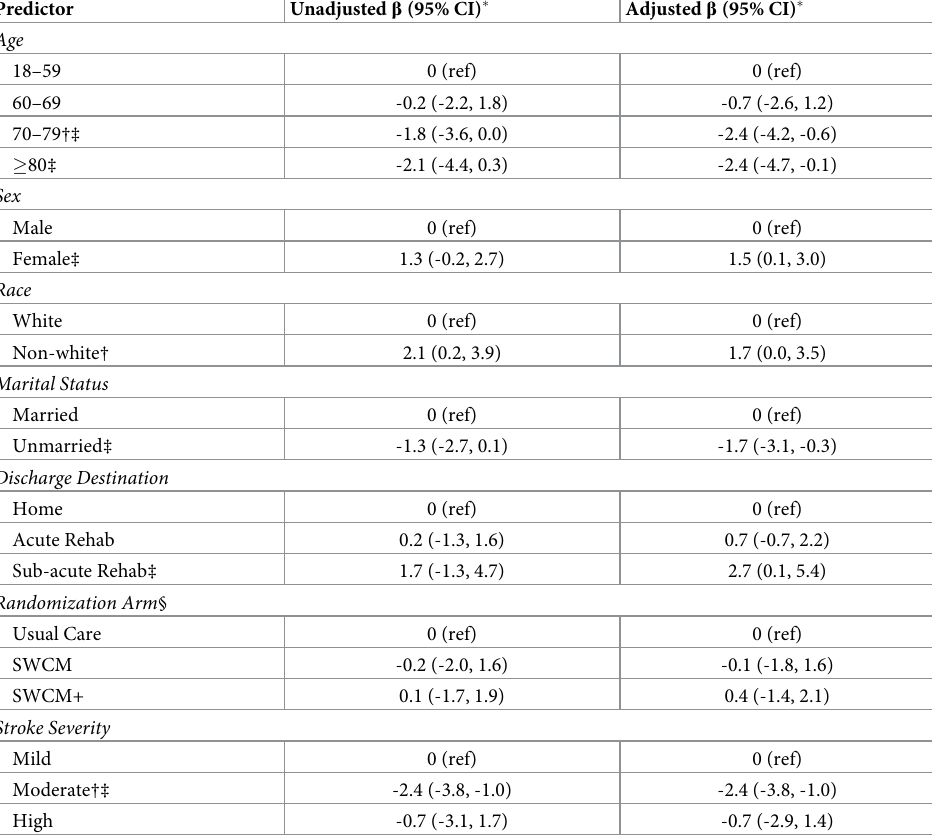
Table 2. Final multivariable linear regression analysis of baseline PHQ-9 score at 7 days (n = 193